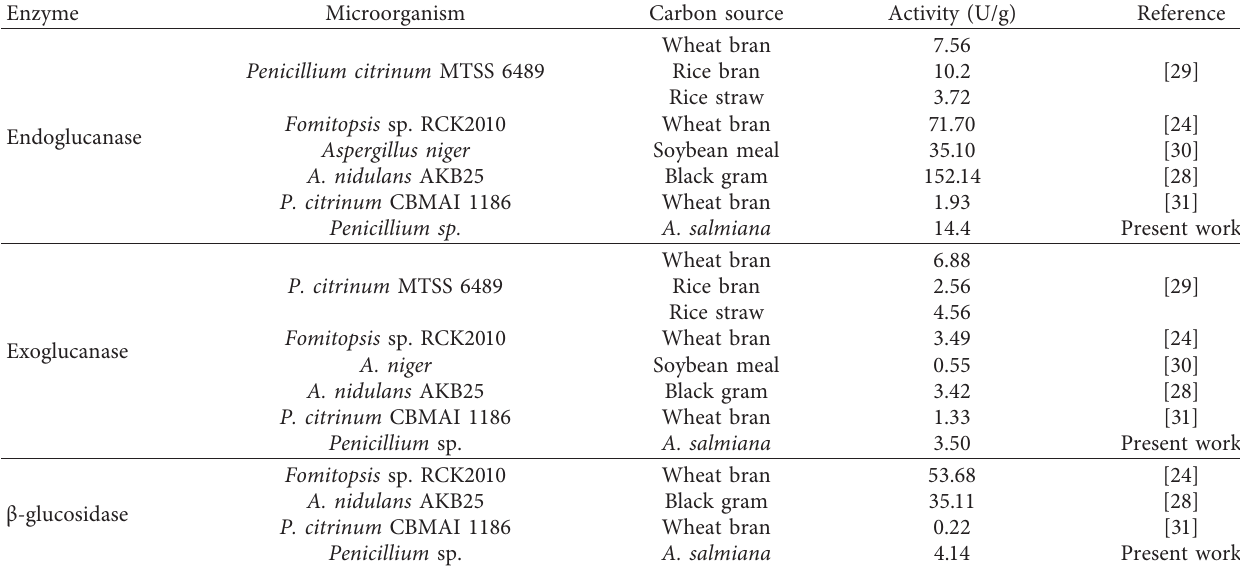
Table 2: Comparison of cellulase production by Penicillium sp. with other microorganisms under SSF. Enzyme